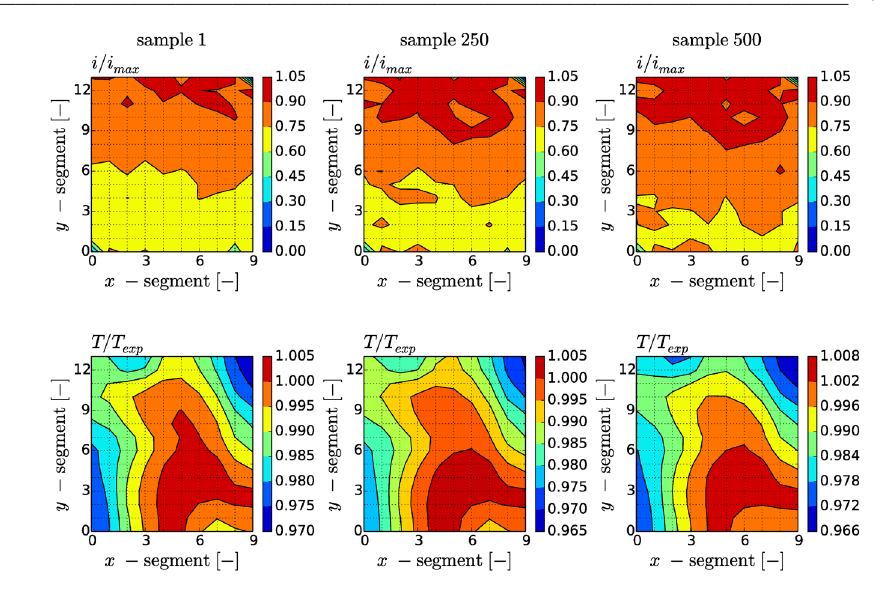
Fig. A5. Distribution of the current density and temperature at maximal load in the AST - F500. The MEA samples D500 and F500 show impact of the AST procedure on distribution of the temperature and current density, see Figs. A4 and Fig. A5. As in the previous cases, distribution of the temperature reflects inlet (segment approx. 8×2) and outlet (segment approx. 1×12) of the thermofluid into the cell meaning that the temperature decreases towards outlet. Due to the AST procedure, slight changes in distribution of the temperature may be identified. Distribution of the current density corresponds to inlet and outlet of the fuel, as indicated in Fig. 5. Furthermore, distribution of the current density varies with increasing number of cycles meaning that area with the lower current density relatively decreases as the AST cycles approaches value 500. It can be also stated that the sample F500 shows more homogeneous distribution of the current density compared to the sample D500 as in the case of the 100